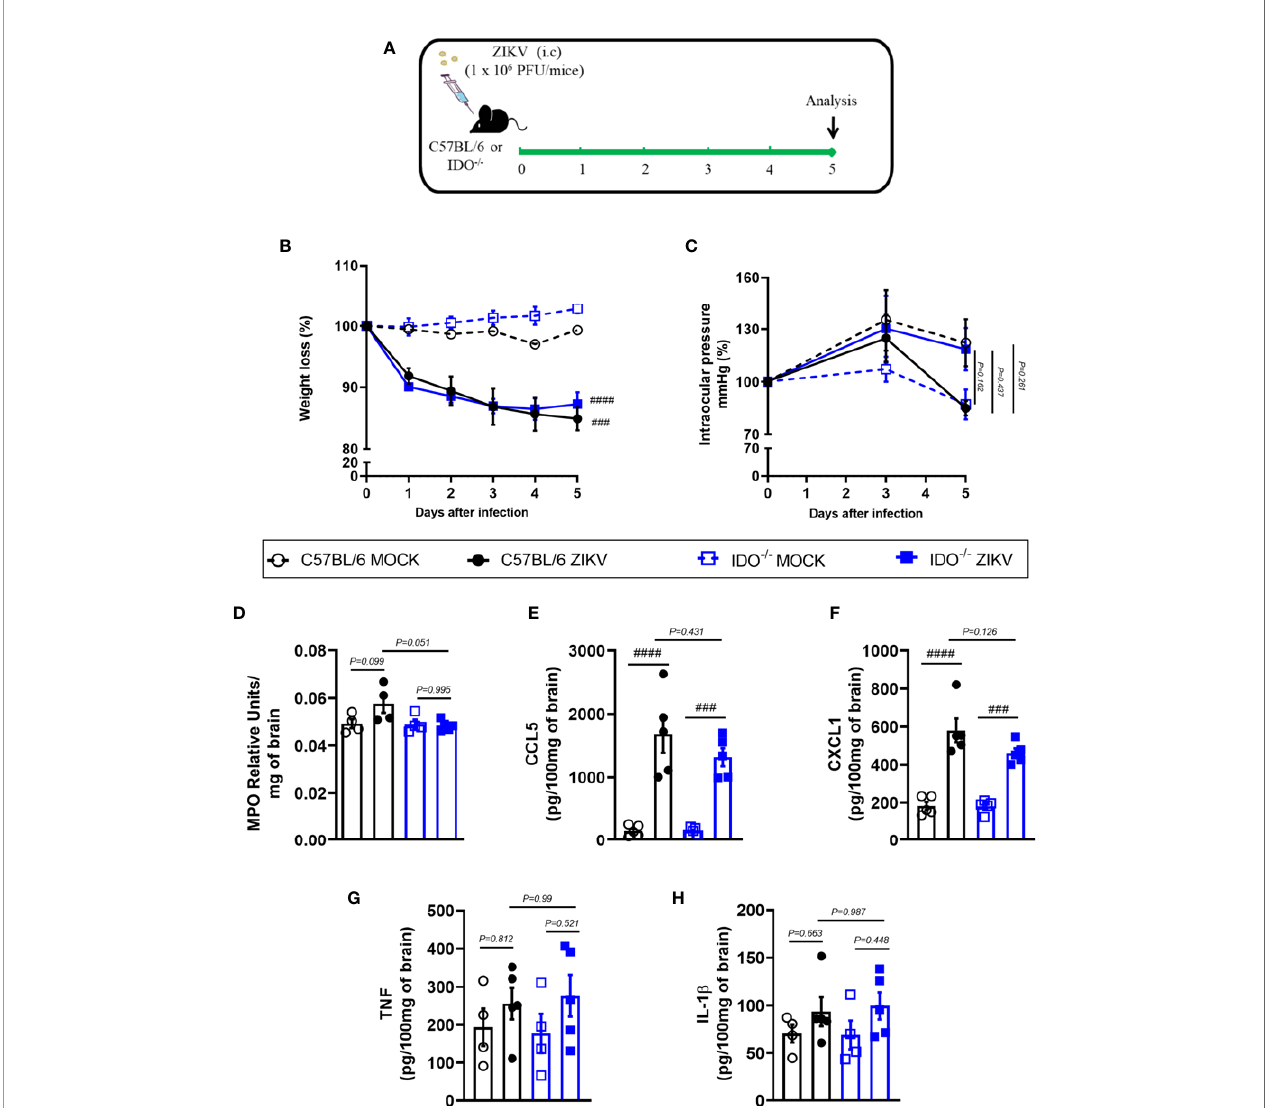
FIGURE 5 | Clinical signs and in fl ammatory parameters after ZIKV infection of WT and IDO -/- mice infected by ZIKV. (A) Experimental schematic representation of experimental strategy. C57BL/6 and IDO-1 -/- were inoculated (intracranial) with 1x10 6 PFU/20 m L of ZIKV. (B) The body weight was evaluated daily and (C) the intraocular pressure was analyzed on days 0, 3 and 5. At day 5 of infection, (D) the brain was harvested and myeloperoxidase absorbance analysis and (E – H) chemokine/cytokine production was assessed. All results are expressed as mean and error bar indicate the standard error (SEM) and are representative of at least two independent experiments. Statistically signi fi cant differences were assessed by Two-way ANOVA plus Tukey ’ s comparisons test (B, C) and One-way ANOVA plus Tukey ’ s comparisons test (D-H). (###) for P < 0,001 and (####) for P < 0,0001 compared to the MOCK